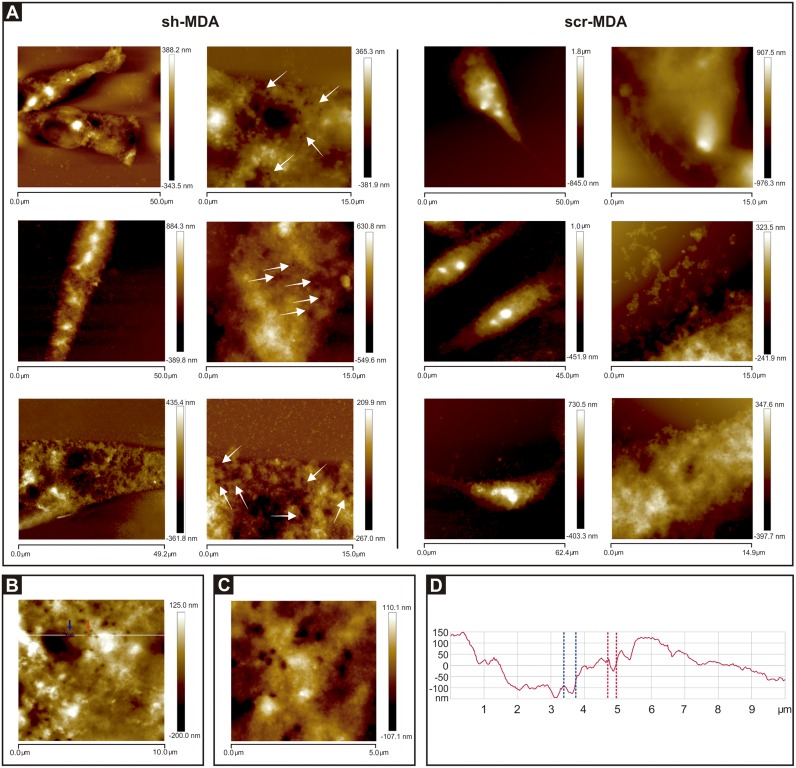
Cells sub-expressing GPAT2 exhibit pore-like structures.A) Representative AFM images of three different sh-MDA and scr-MDA cells revealed pore-like structures only on the surface of sh-MDA cells indicated with white arrows in 15.0 μm x 15.0 μm images. B and C) High-resolution 10.0 μm x 10.0 μm and 5.0 μm x 5.0 μm images, respectively, of one sh-MDA cell showing pore-like structures. D) Section analysis showing the size of two pores along the white line shown in the Fig 6B. The dashed red and blue lines define the diameter and depth of the pores indicated with red and blue arrows, respectively, in Fig 6B. Fig 6B is the section analysis of the cell shown in Fig 4J.